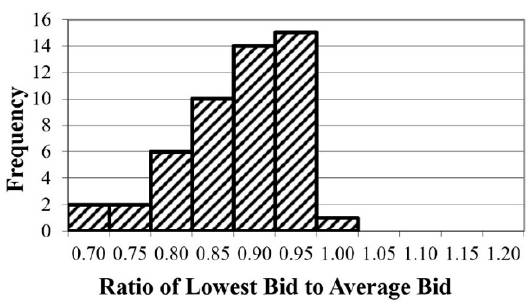
Figure 8. Distribution of lowest bid using ratio to average bid.